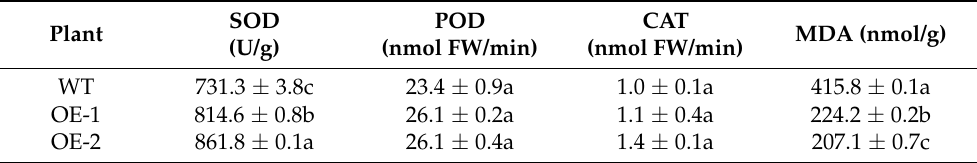
Table 2. Contents of oxidants and antioxidant enzymes in wild-type and OsMYBAS1 -overexpre- ssing